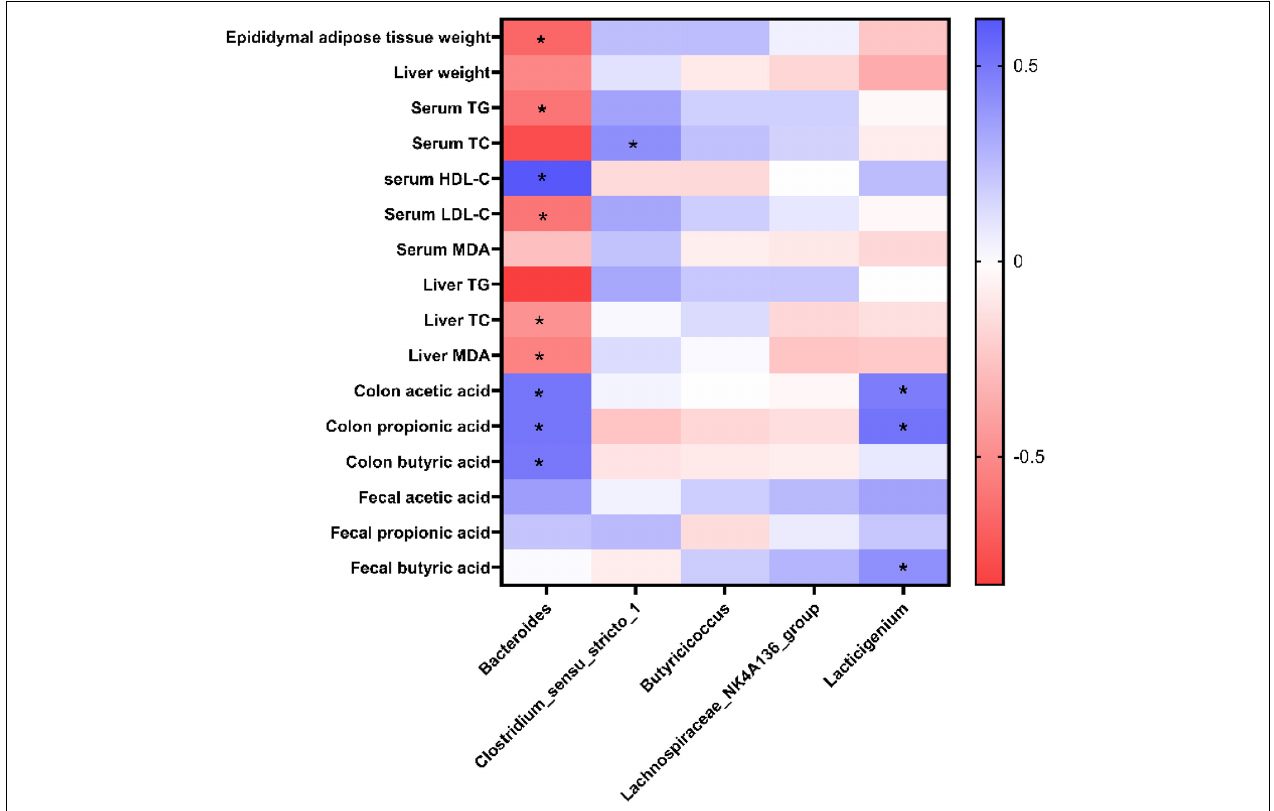
FIGURE 8 | Heatmap of Spearman’s correlation between dominant genera and obesity-related parameters. *Significance was set at P <